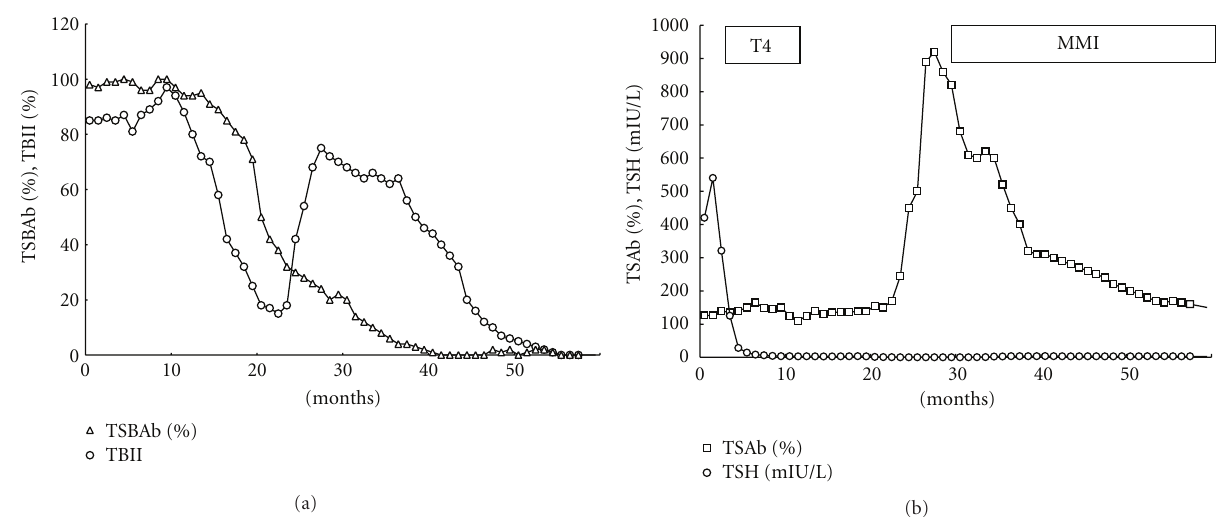
Figure 2: The clinical course of one of the 2 patients, who initially had TSBAb-positive hypothyroidism and then developed TSAb- positive Graves’ hyperthyroidism (Table 1, Ic). A 45-year-old woman with TSBAb-positive hypothyroidism developed TSAb-positive Graves’ hyperthyroidism. She had TSBAb-positive hypothyroidism ((a), (cid:4) ) with high serum TSH ((b), ◦ ) and then developed TSAb-positive Graves’ hyperthyroidism ((b), (cid:2) ) with undetectable serum TSH ((b), ◦ ). TSBAb was dominant initially ((a), (cid:4) ), and then TSAb became dominant ((b), (cid:2) ). TBII (TSH-binding inhibitory immunoglobulin) ((a), ◦ ) reflects TSBAb- and TSAb-activity. A patient with TSBAb- positive hypothyroidism developed TSAb-positive Graves’ hyperthyroidism. She was treated with T4 and then with